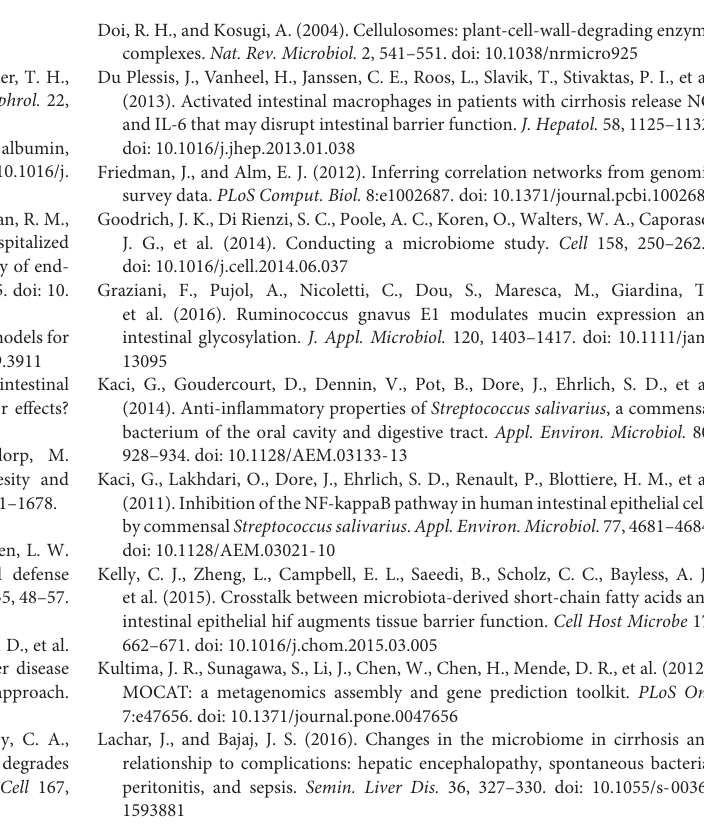
FIGURE S5 | Schematic illustration of specific pathways in sugar biomass fermentation. TABLE S1 | Detailed clinical information for all patients and healthy volunteers. TABLE S2 | Detailed information on microbial gene richness, gene richness, and Shannon index for each sample. TABLE S3 | Detailed information on the correlation analysis between microbial richness and clinical indices. TABLE S4 | Detailed information on edges of the inter-microbiome correlation networks in each group. TABLE S5 | Detailed information on some edges enhanced in compensated patients as compared to healthy controls. TABLE S6 | Detailed information on retention time, molecular weight and VIP value for 75 differential metabolites. TABLE S7 | Detailed information on functional annotations in various